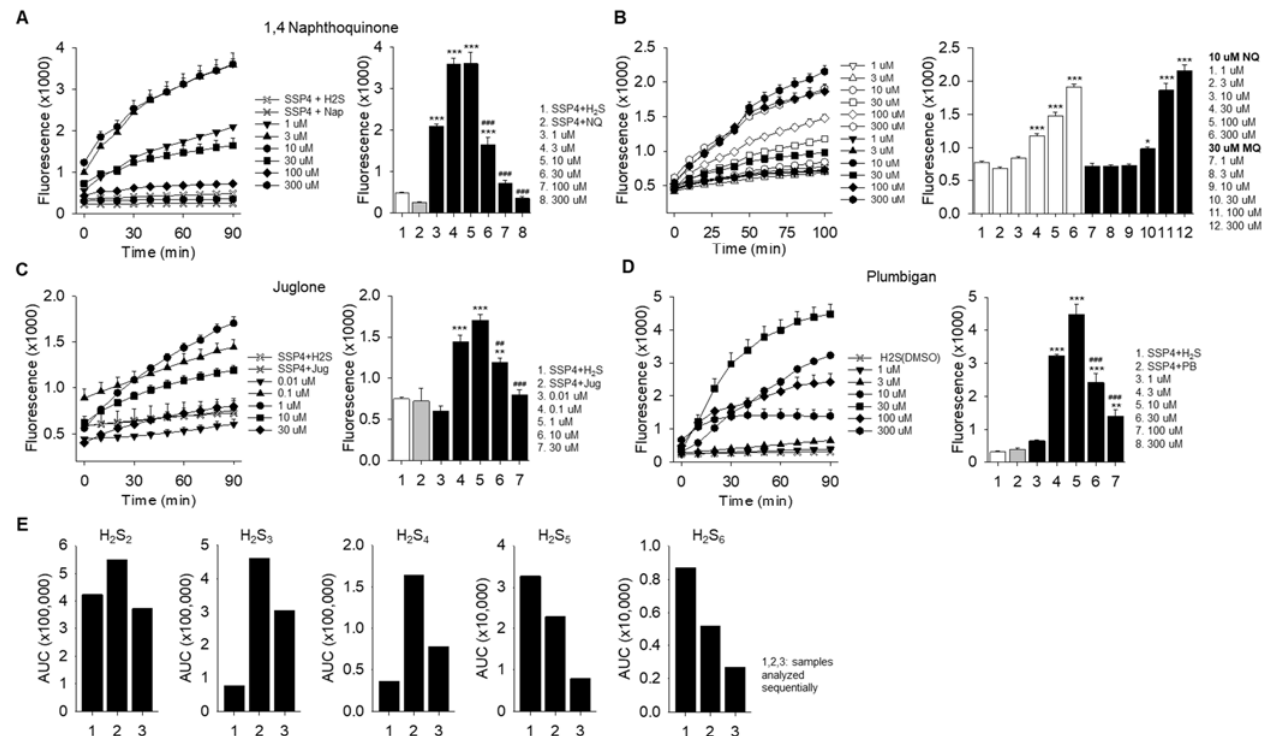
Figure 2. Naphthoquinones oxidize H 2 S to polysulfides (SSP4 fluorescence). ( A ) Effect of increasing concentrations of 1,4-naphthoquinone (1,4-NQ) with constant 300 µ M H 2 S, or ( B ) effect of 10 and 30 µ M 1,4-NQ with increasing concentrations of H 2 S. ( C , D ) Effect of increasing concentrations of juglone (Jug) or plumbagin (Pbn) on SSP4 fluorescence from 300 µ M H 2 S. All naphthoquinones ini- tially increased, then decreased SSP4 fluorescence, whereas H 2 S concentration-dependently increased fluorescence at both concentrations of 1,4-NQ. ( E ) LC-ESI-HRMS identification of IAM-derivatized polysulfides produced from 1 mM H 2 S and 1 mM 1,4-NQ. Samples were derivatized after 10 min with 5 mM IAM and three aliquots (1, 2, 3) were analyzed serially at approximately 1 h intervals. ( A – D ) Mean + SE, n = 4 wells per treatment. *, p < 0.05; **, p < 0.01; ***, p < 0.001 compared to buffer; ##, p < 0.01; ###, p < 0.001 compared to maximum response.